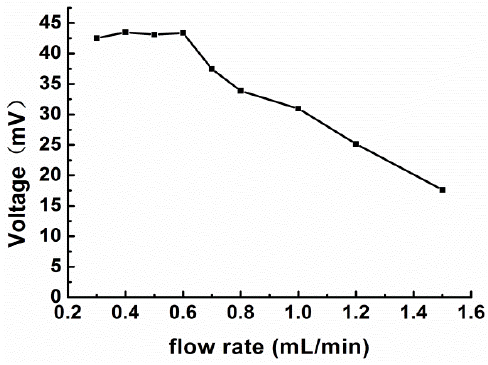
Figure 4. Effect of flow rate on the response of the FIA biosensor. A 350 μL sample of a